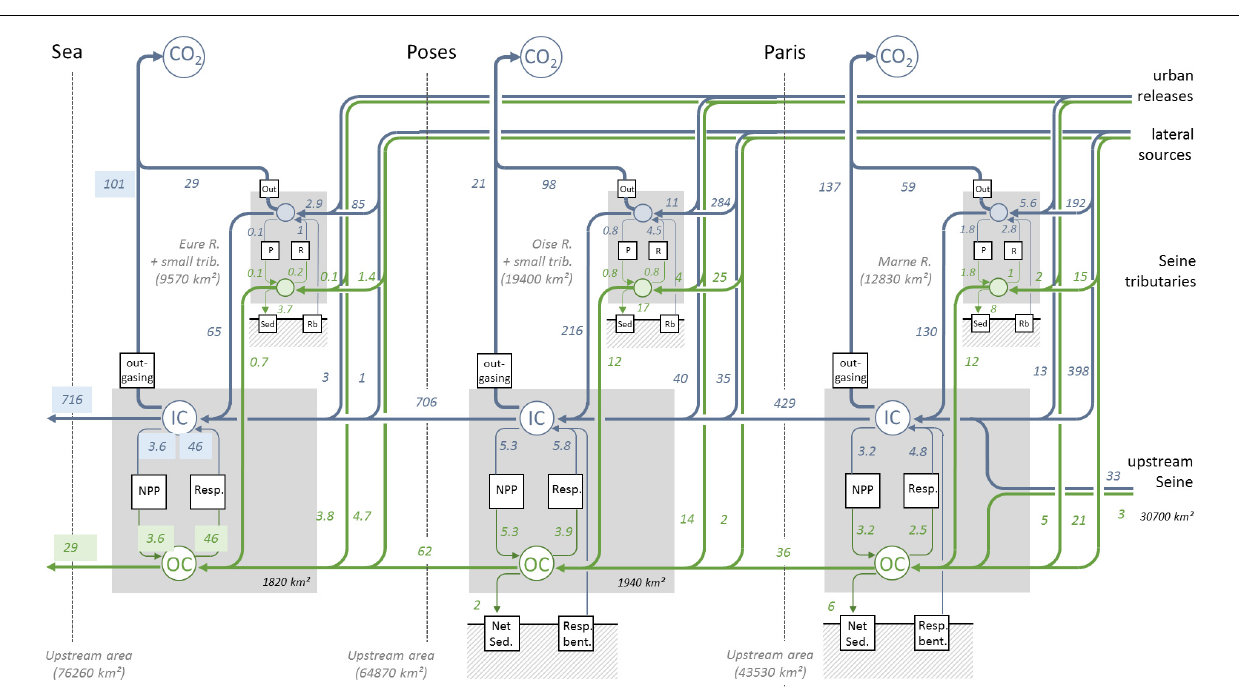
main axis of the Seine between Poses and Paris. 71% of